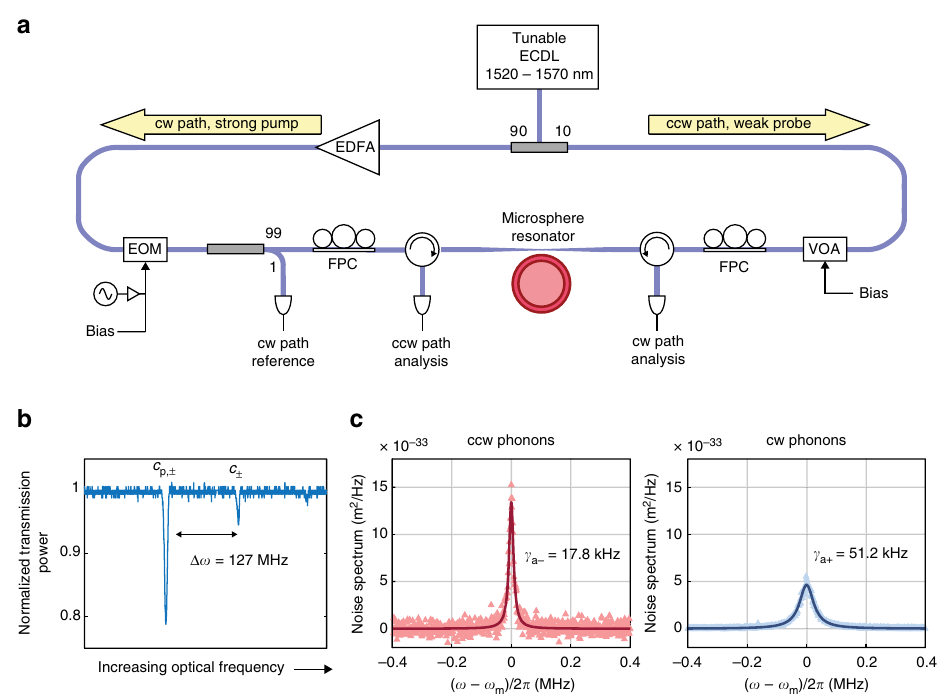
Fig. 2 Measurement setup for chiral optomechanical refrigeration. a We perform the experiment using a silica whispering-gallery microsphere resonator that is interfaced via tapered optical fi ber. A 1520 to 1570 nm tunable external cavity diode laser (ECDL) generates the asymmetric cw pump (strong) and ccw probe (weak) sources. An Erbium-doped fi ber ampli fi er (EDFA) controls the cw pump power, for optomechanical cooling 26 and for monitoring the cw phonon spectrum. An electro optic modulator (EOM) is employed to measure detuning of anti-Stokes scattered light from its optical mode through via induced transparency 19 . A variable optical attenuator (VOA) is used to control the ccw probe. Fiber polarization controllers (FPC) are used to optimize coupling between the fi ber and resonator in both directions. b The optical modes are mapped by measuring dropped power from the tapered fi ber. c Dramatic chiral cooling of the high- Q ( ω m = 2 π × 127 MHz) phonon populations is immediately observed with strong cw pumping (140.9 μ W). ccw phonons are also cooled slightly due to the ccw probe. Solid lines are Lorentzian fi ts to the data